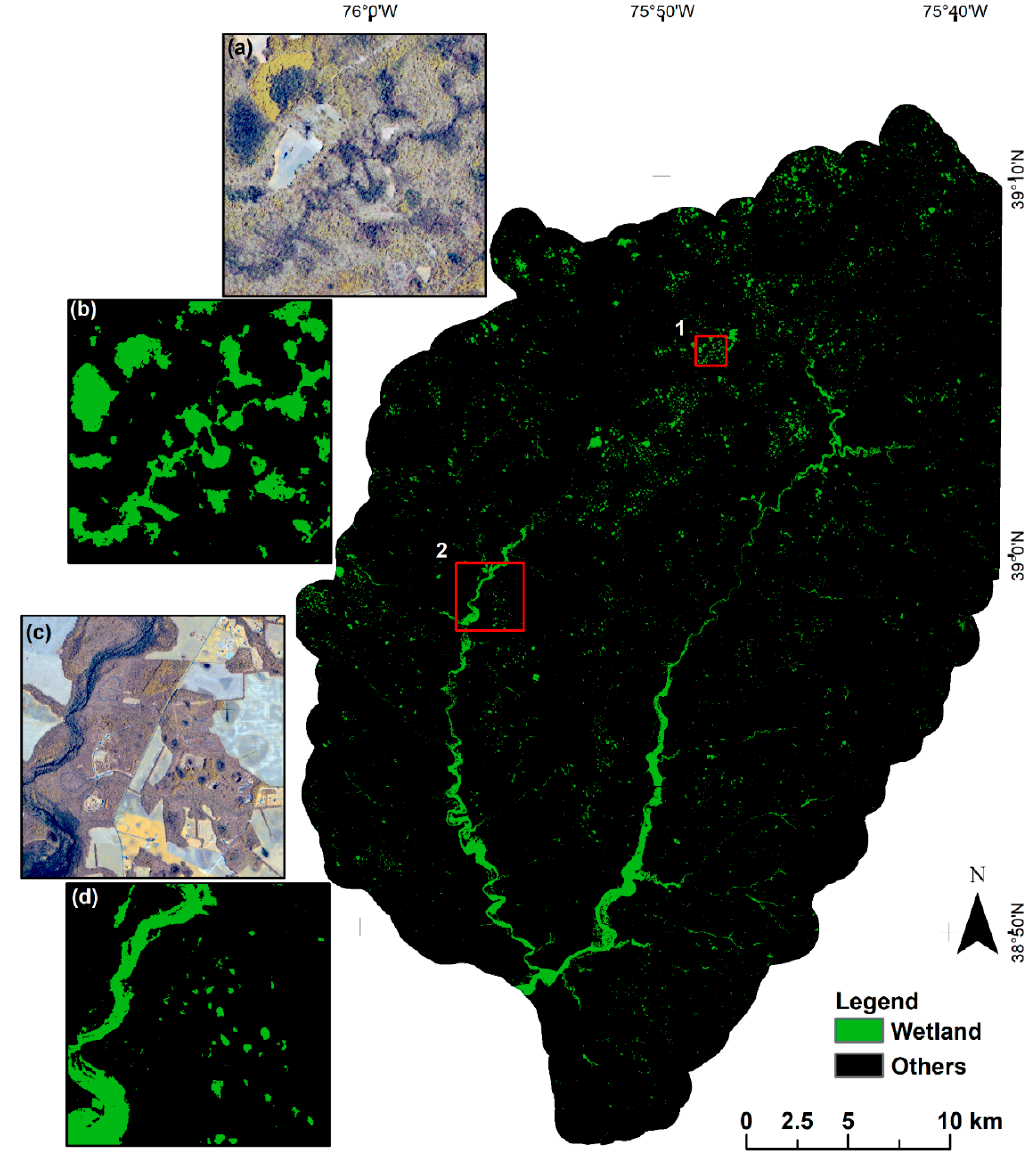
Figure 6. Forested wetland inundation map classified using WorldView-3 (WV3) + topographic wetness index (TWI) using deep learning method. ( a , b ) are zoom-in WV3 imagery and deep learning inundation map, respectively in depressional wetlands in box 1. ( c , d ) are zoom-in WV3 imagery and deep learning inundation map, respectively in floodplains in box 2. WV3 imageries in ( a ) and ( c ) are shown in false color (Red channel: Near-IR2, Green channel: Red Edge, and Blue channel: Yellow). Table 2. Accuracy assessments using field data. The variables in the parentheses are the data input used for our deep learning network or the random forest model. WV3: WorldVview-3, DEM: Digital Elevation Model, TWI: Topographic Wetness Index.